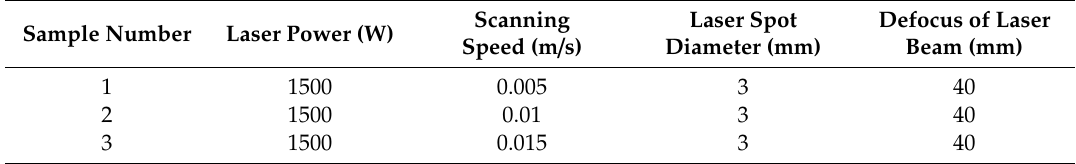
Table 3. Experimental parameters of laser cladding.